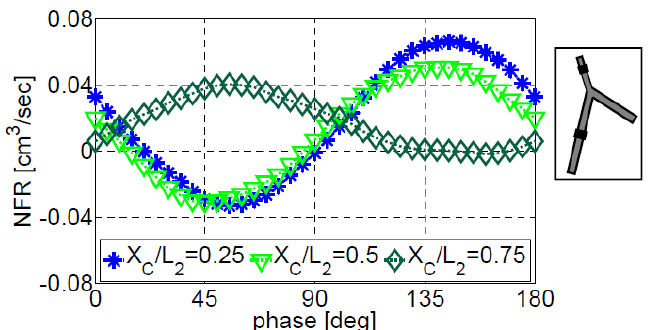
/ 0.75 X L = . Three 1 C